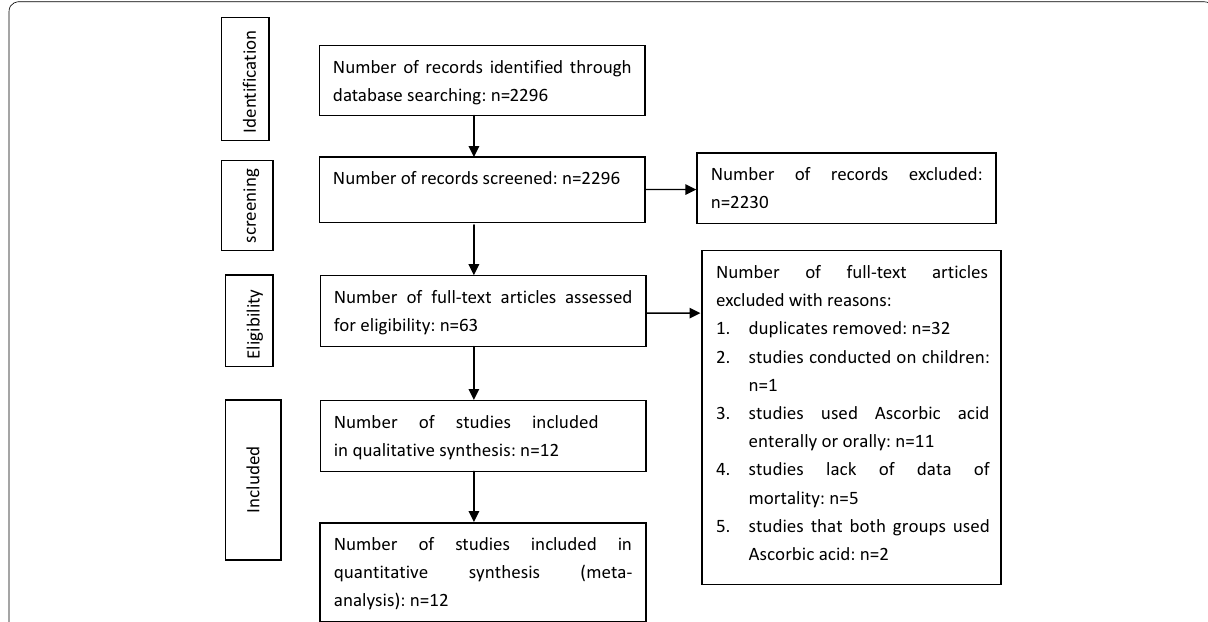
Fig. 1 Study flow diagram